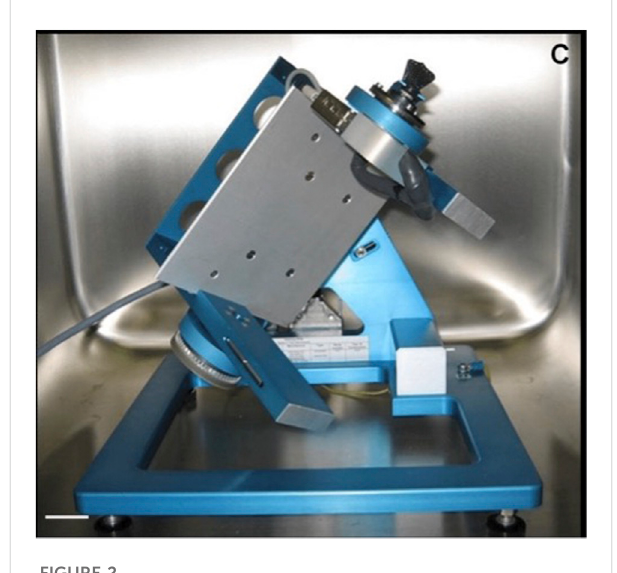
FIGURE 2 Random positioning machine (Kopp,